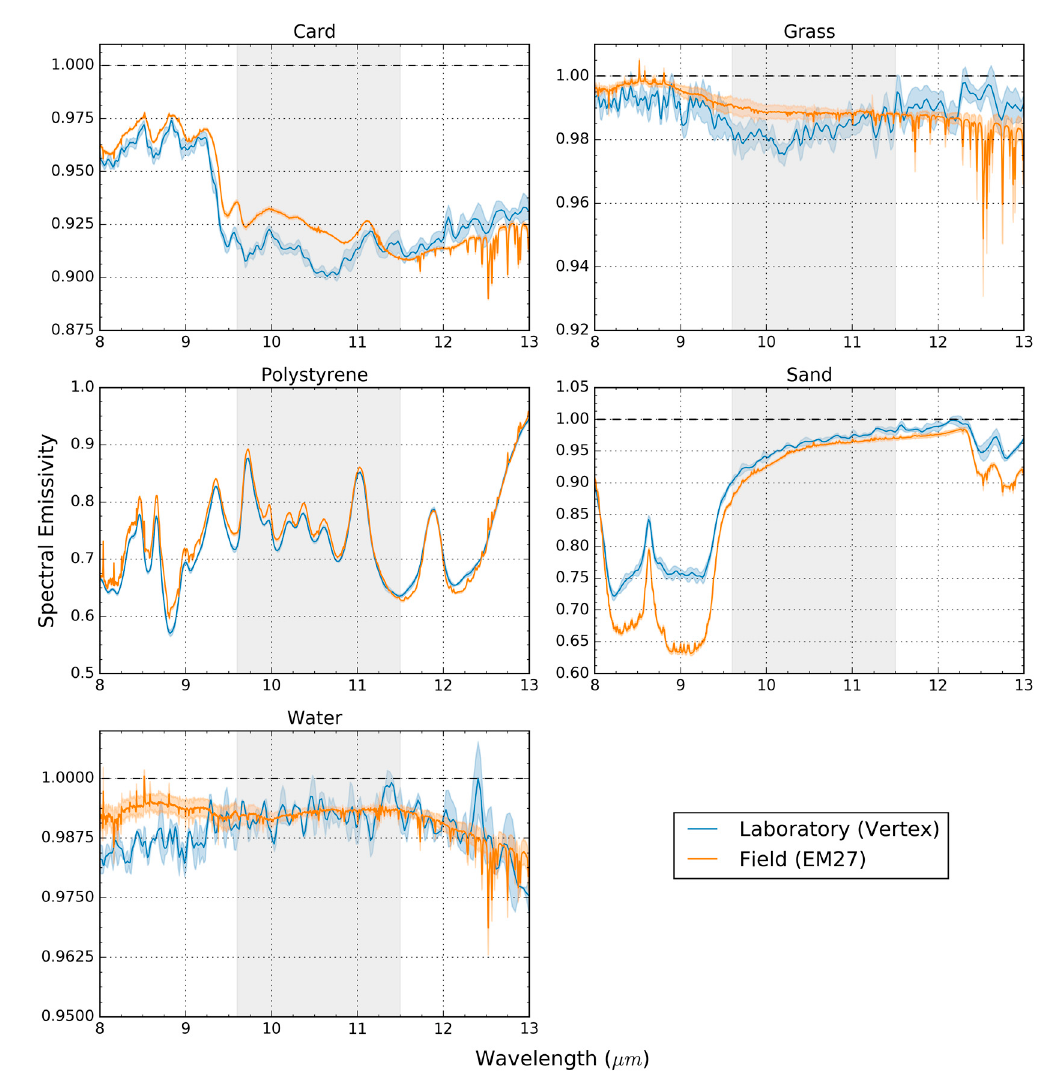
Figure 9. Laboratory-measured (Vertex) and field-measured (EM27) surface spectral emissivities of five different samples, as measured in Alconbury (UK) in May 2018. Values are the mean of all measurements, with the surrounding shaded area indicating the corresponding uncertainty as detailed in Section 3.1. The numbers of measurements made of each sample were listed in Table 4. Grey shaded area indicates the spectral range of the Heitronics KT15.85 IIP radiometer used for the emissivity box